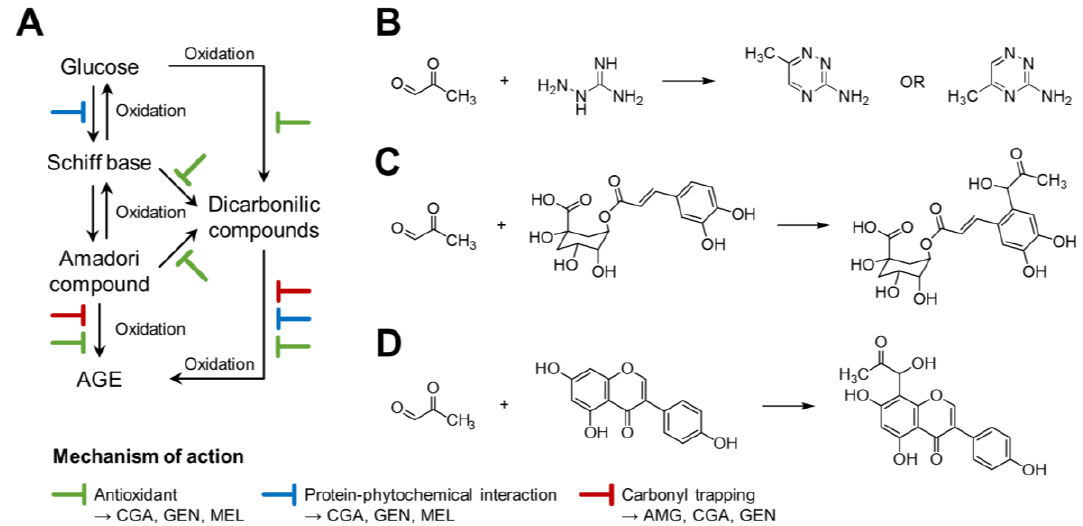
Figure 9. Illustrative diagram of the inhibitory mechanism ( A ) of coffee silverskin extract and the compounds (aminoguanidine, chlorogenic acid, genistein, and melatonin) studied in this work and the reactions of methylglyoxal trapping by aminoguanidine ( B ), chlorogenic acid ( C ), and genistein ( D